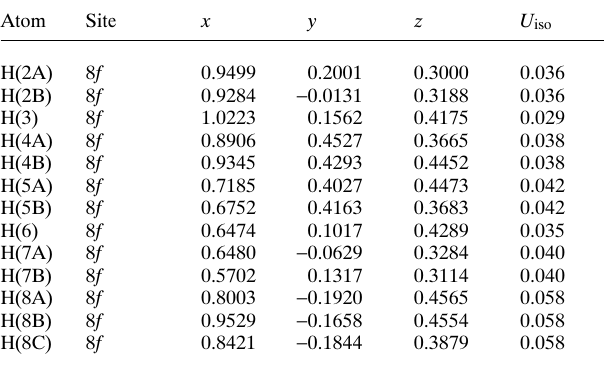
Table 2. Atomic coordinates and displacement parameters (in Å 2 )